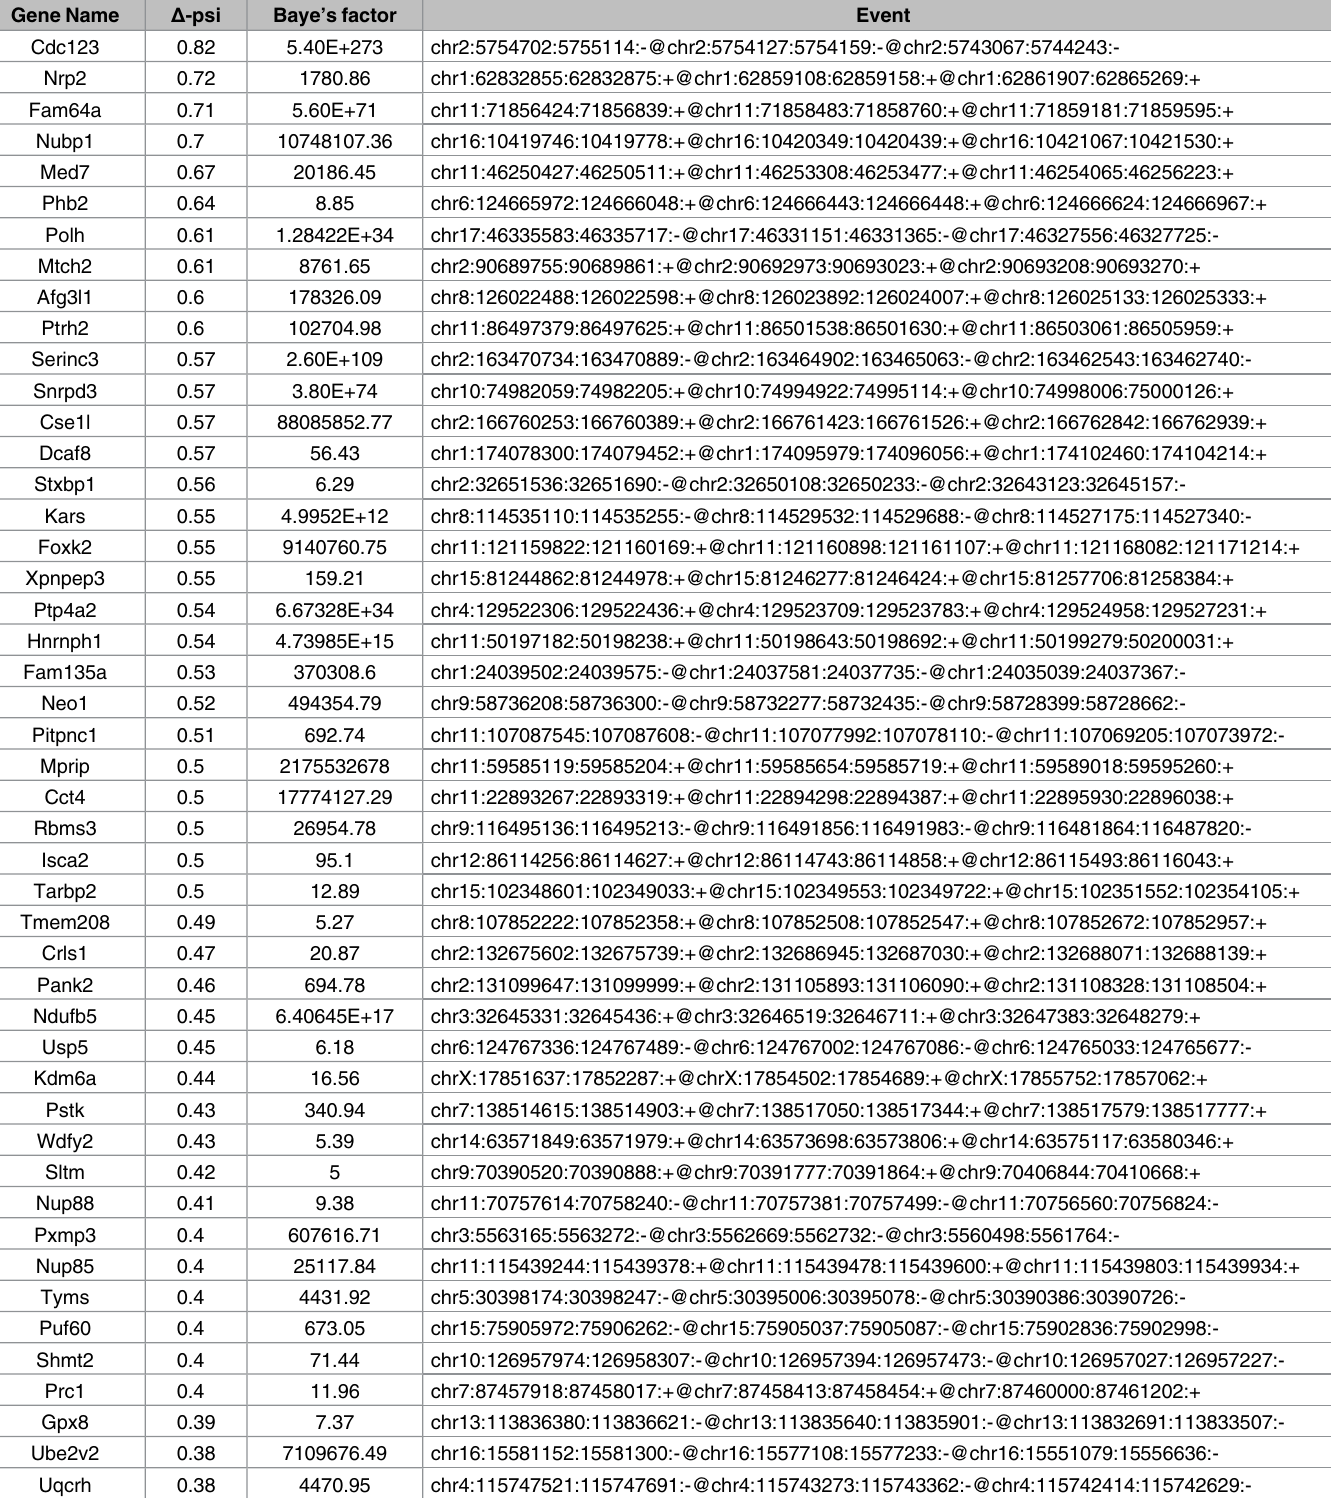
Table 2. SMN-dependent exon retention events ranked by percent